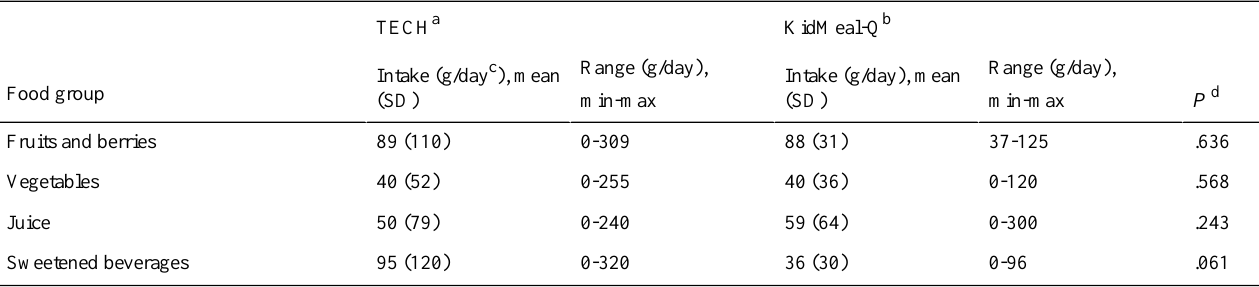
Table 1. Mean daily food intake estimated by means of TECH andKidMeal-Q